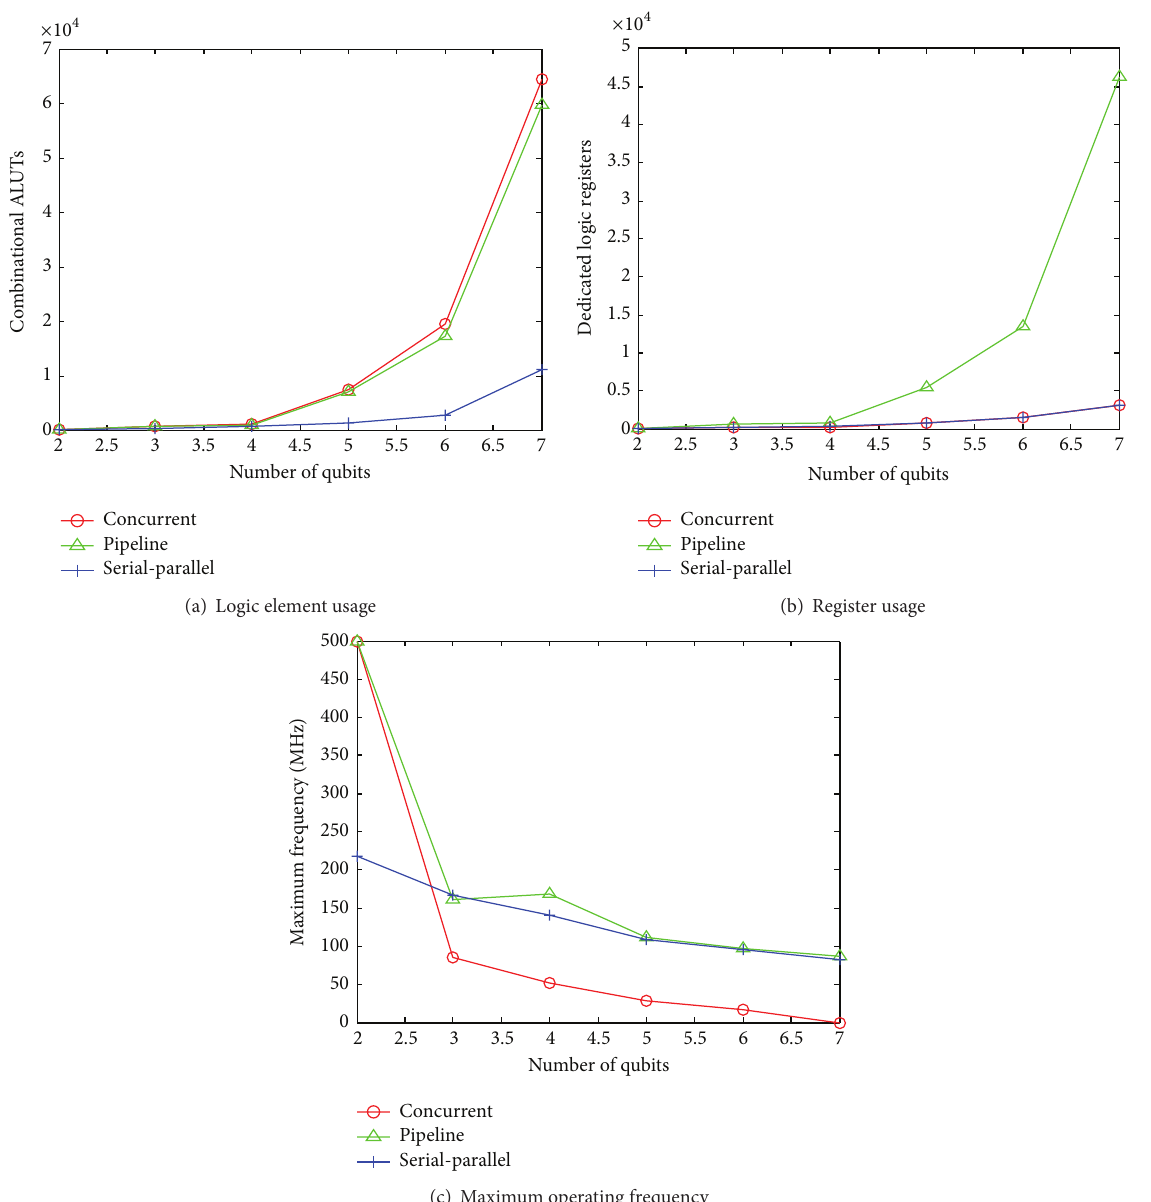
Figure 19: Resource utilization and maximum operating frequency for different emulation architectures of Grover’s search (based on 24-bit fixed point